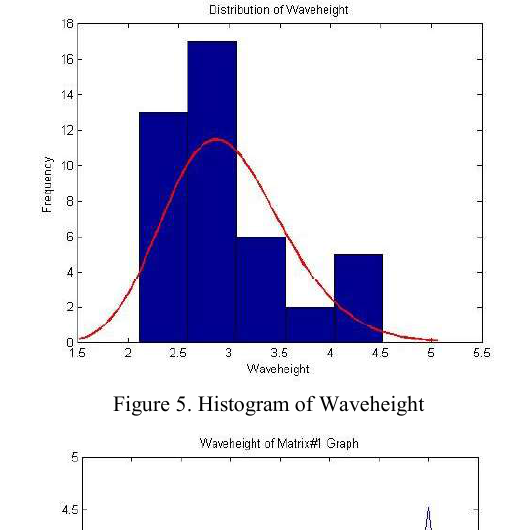
Figure 4. Local and Initial Incidence Angle